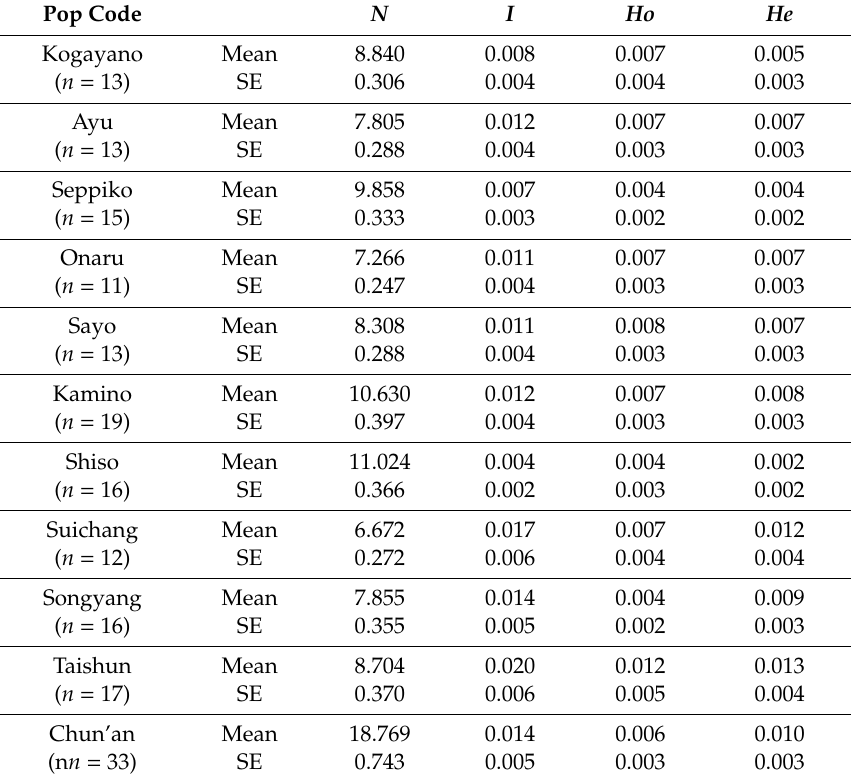
Table 2. Genetic characters of 11 Meehania montis-koyae populations from China and Japan based on 338 SNPs by MIG-seq analysis. I = Shannon’s Information Index, Ho = observed heterozygosity, He = expected